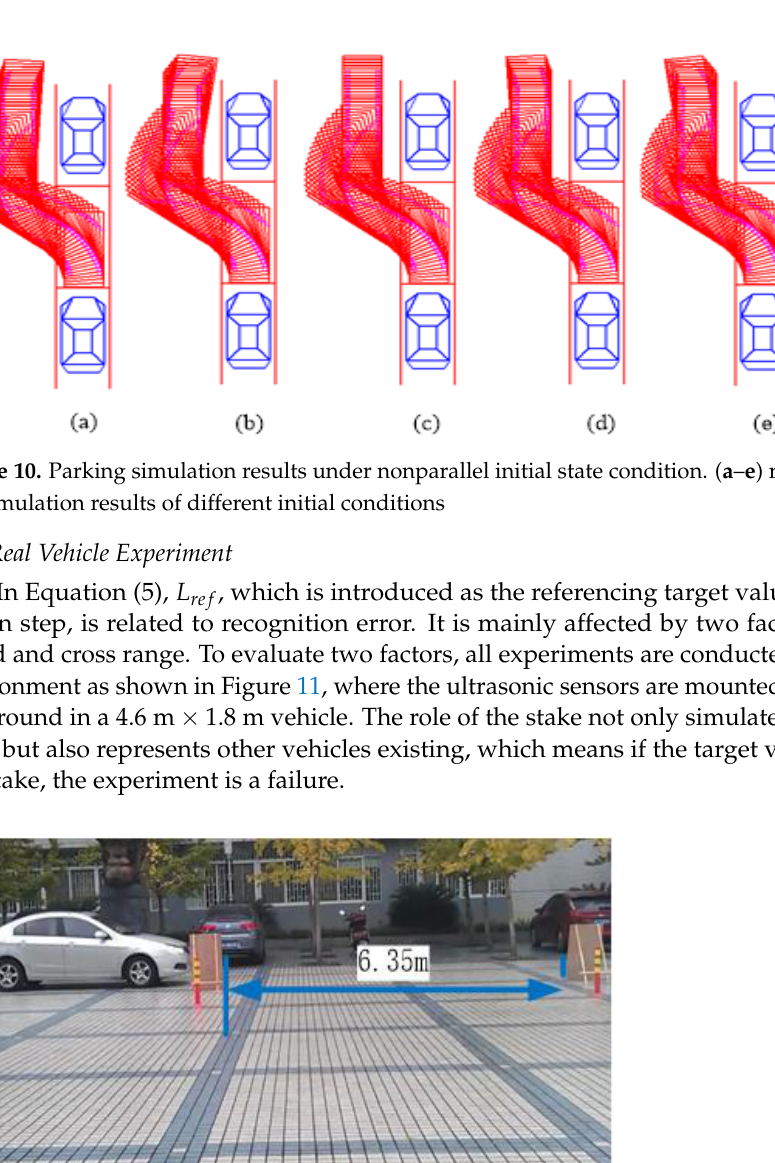
Figure 9. Simulation model of the automatic parking system in Simulink.